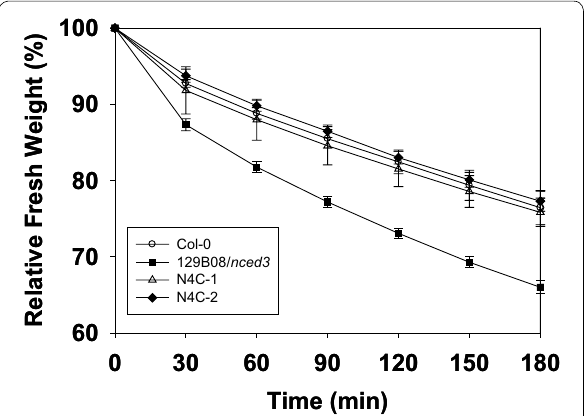
Fig. 6 Relative fresh weight of rosette leaves excised from 3‑week‑ old Col‑0, 129B08/ nced3 mutant, and two N4C transgenic